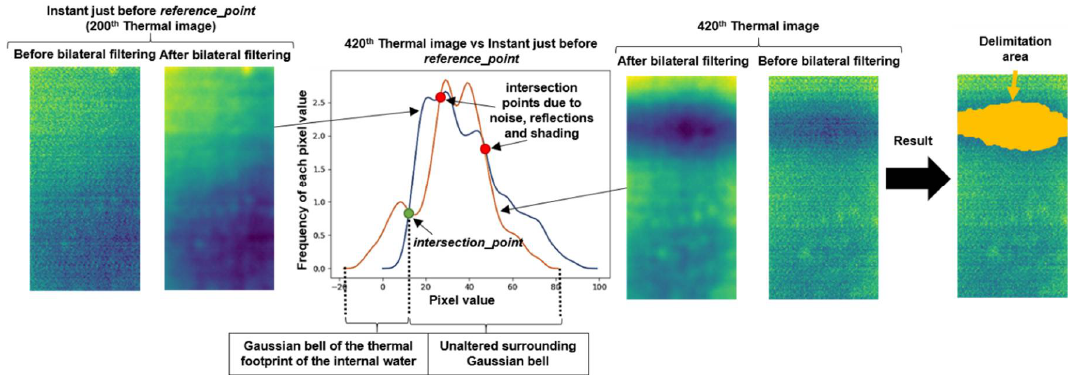
Figure 8. Step 2 result applied to the 420th thermal image belonging to the Test_1.